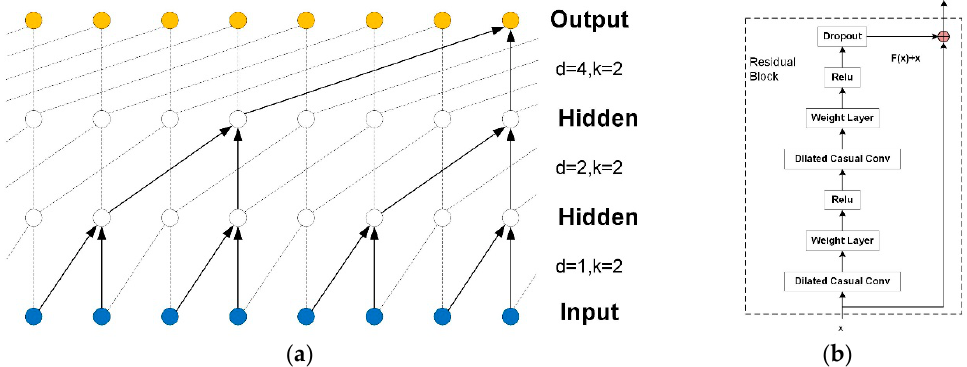
Figure 1. ( a ) Architectural elements in a temporal convolutional network (TCN); ( b ) residual structure of TCN.